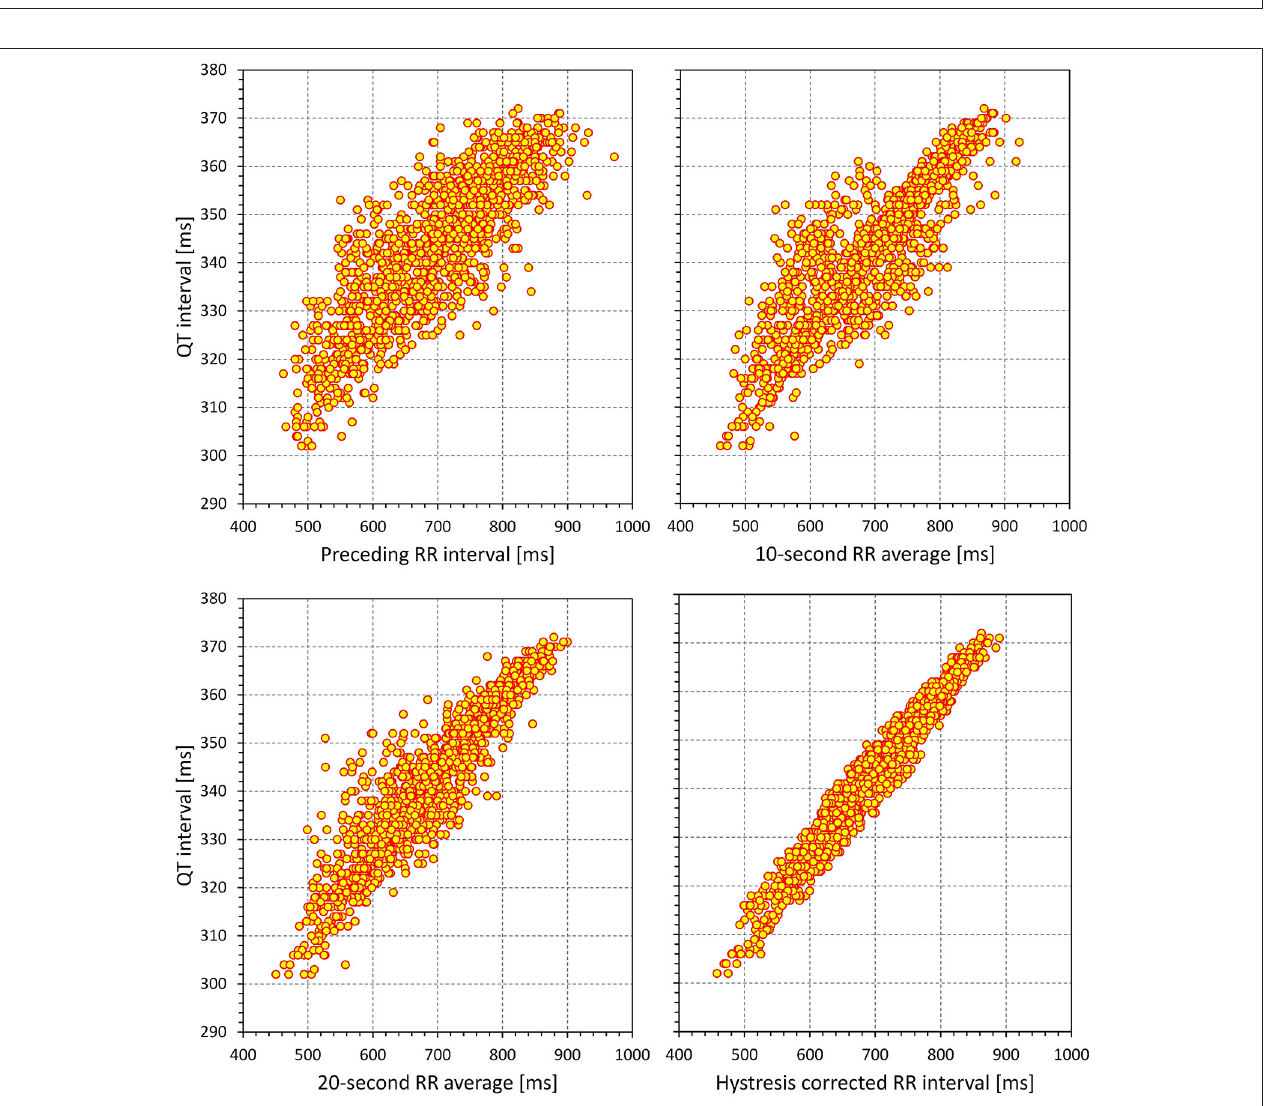
FIGURE 14 | the red circle and blue square marks correspond to females and males, respectively. The red and blue horizontal lines show the mean values of the residual differences in females and males, respectively. The light-coloured red and blue bands show the spans of mean ± standard deviation of the residual differences in females and males, respectively; the light-coloured violet bands show the overlap of the mean ± standard deviation bands between both sexes.